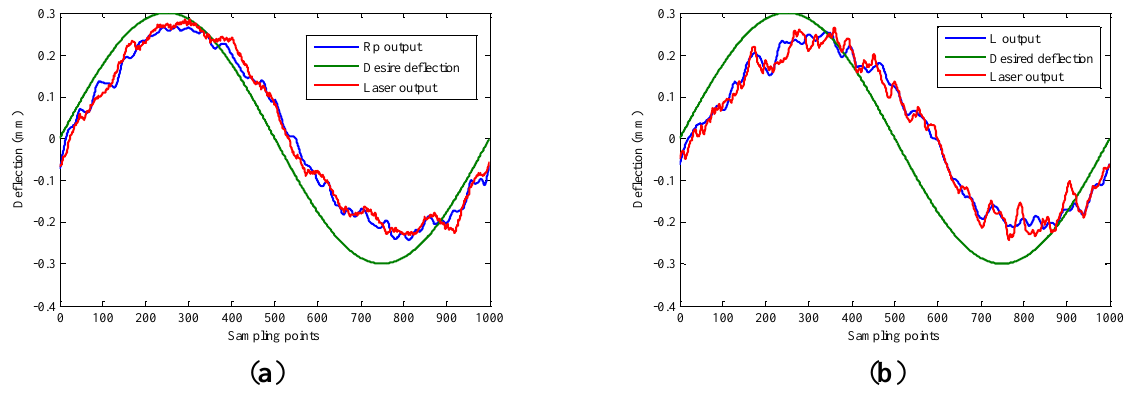
Figure 9. Measured deflection from laser and inductive sensors with Rp ( a ) and L ( b ) as feedback